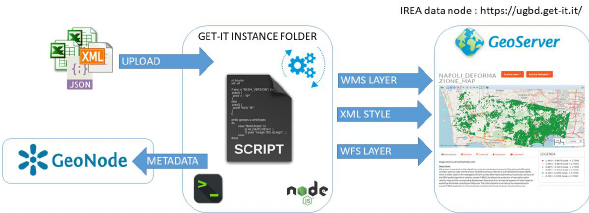
Figure 3. Web deployment of metadata, mean deformation velocity maps, and time series of cumulative